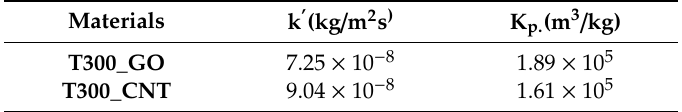
Table 3. Computational fluid dynamics (CFD) estimated kinetic parameters k´ and K p .